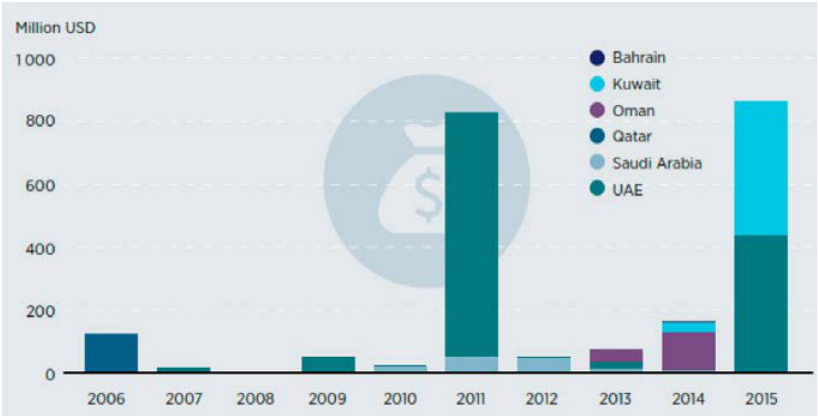
Figure 1: Investment in GCC renewable energy (Masud et al.,